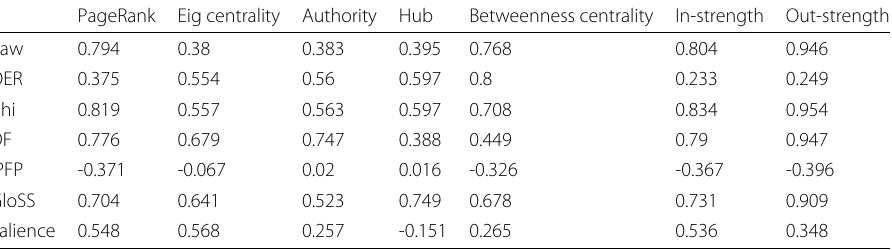
Table 16 The correlation between the network measures of diseases and disease prevalence, for different constructed networks PageRank Eig centrality Authority Hub Betweenness centrality In-strength